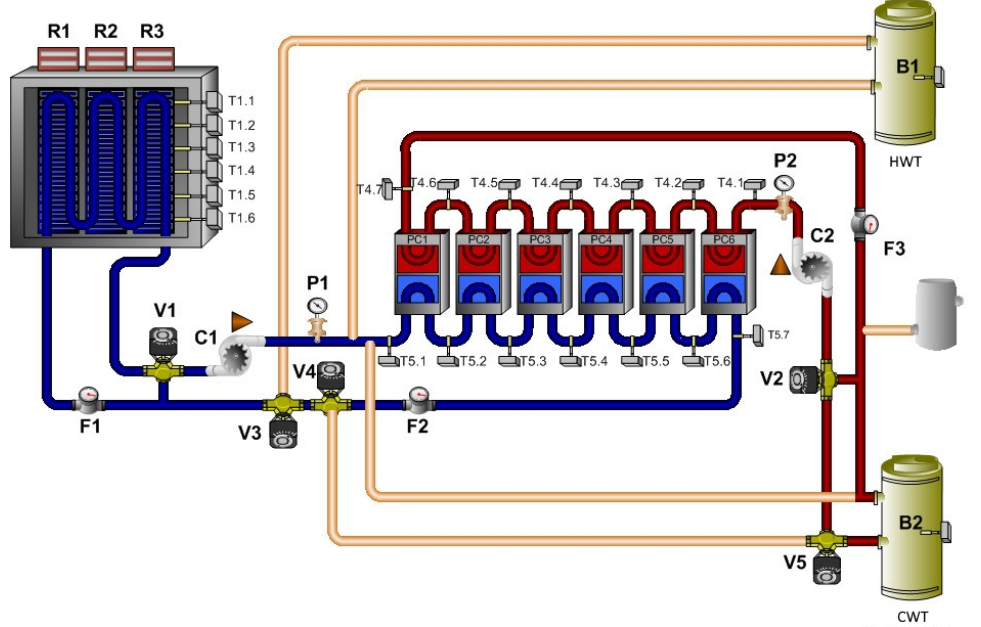
Figure 9. Mode: cooling by